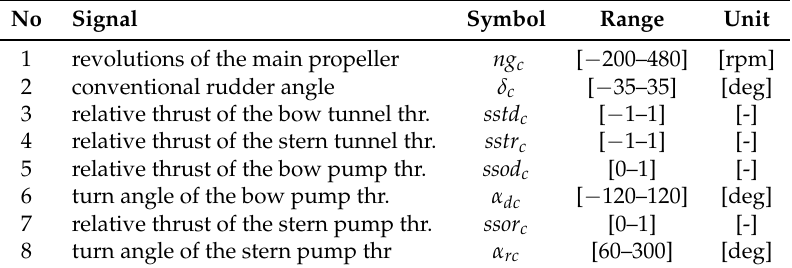
Table 1. Characteristics of the input signals for ship’s propellers and rudder [11]. No Signal Symbol Range Unit 1 revolutions of the main propeller ng c [ − 200–480] [rpm] 2 conventional rudder angle δ c [ − 35–35] [deg] 3 relative thrust of the bow tunnel thr. sstd c [ − 1–1] [-] 4 relative thrust of the stern tunnel thr. sstr c [ − 1–1] [-] 5 relative thrust of the bow pump thr. ssod c [0–1] [-] 6 turn angle of the bow pump thr. α dc [ − 120–120] [deg] 7 relative thrust of the stern pump thr. ssor c [0–1] [-] 8 turn angle of the stern pump thr α rc [60–300] [deg] Symbols shown in the third column are used throughout the whole paper.